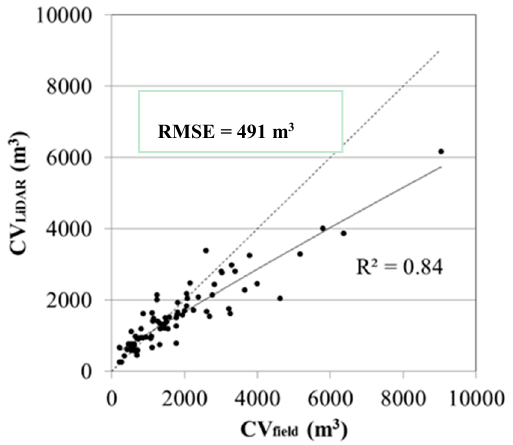
Figure 10. Scatterplot between canopy volume predicted using the LiDAR-derived values of canopy height and crown diameter (Equation (1)) and the field measured values. The dashed line is the 1:1 equivalence between measured and predicted values and the solid line is the best-fit regression curve (polynomial).